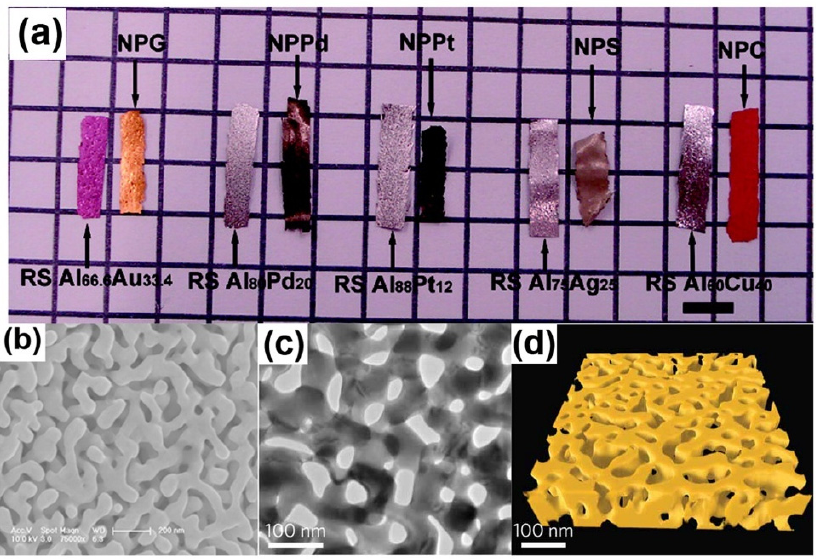
Figure 1. Characterization of nanoporous metals: ( a ) Macrographs of alloys and corresponding nanoporous metals ribbons. Reproduced with permission from Reference